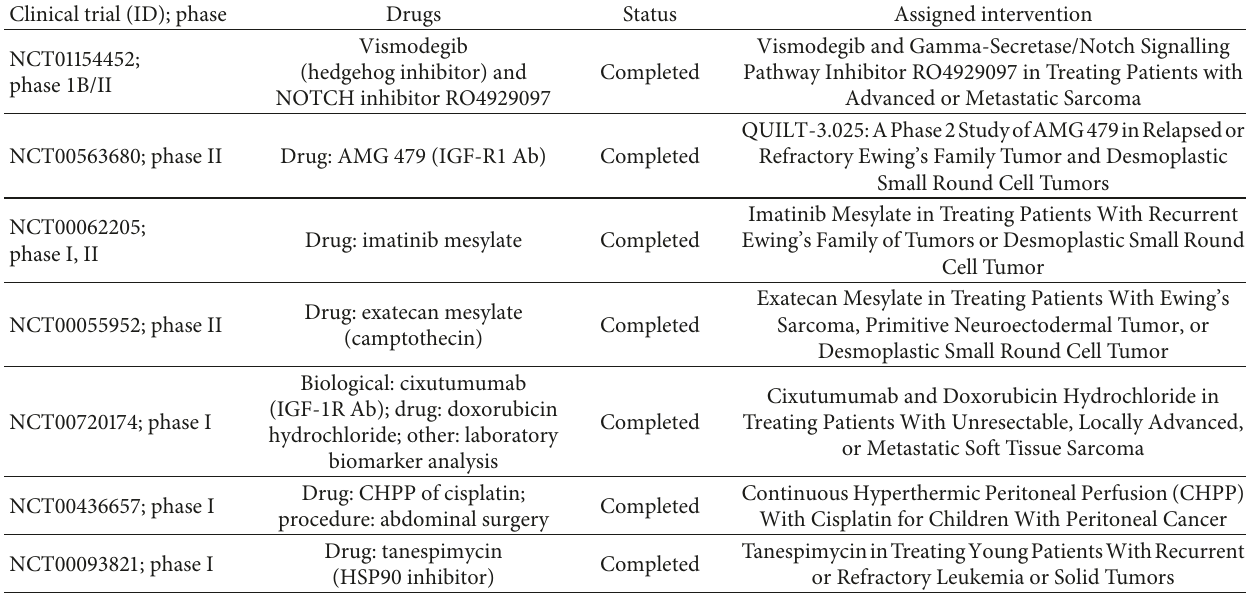
Table 2: Clinical trials recently completed in DSRCT.